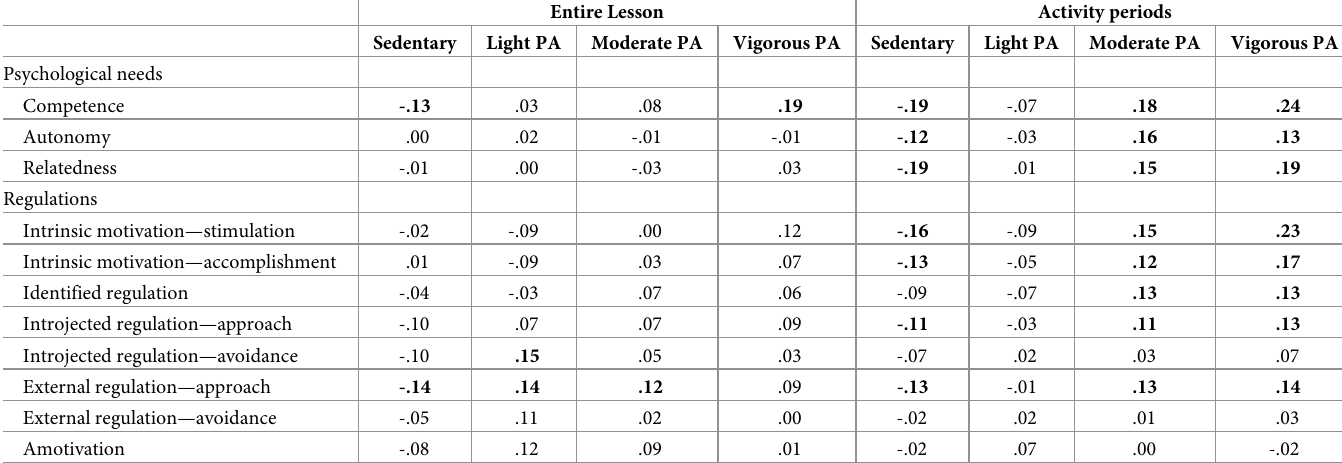
Table 2. Correlations between motivational variables and PA-related behaviors (coefficients in bold are significant at the .05